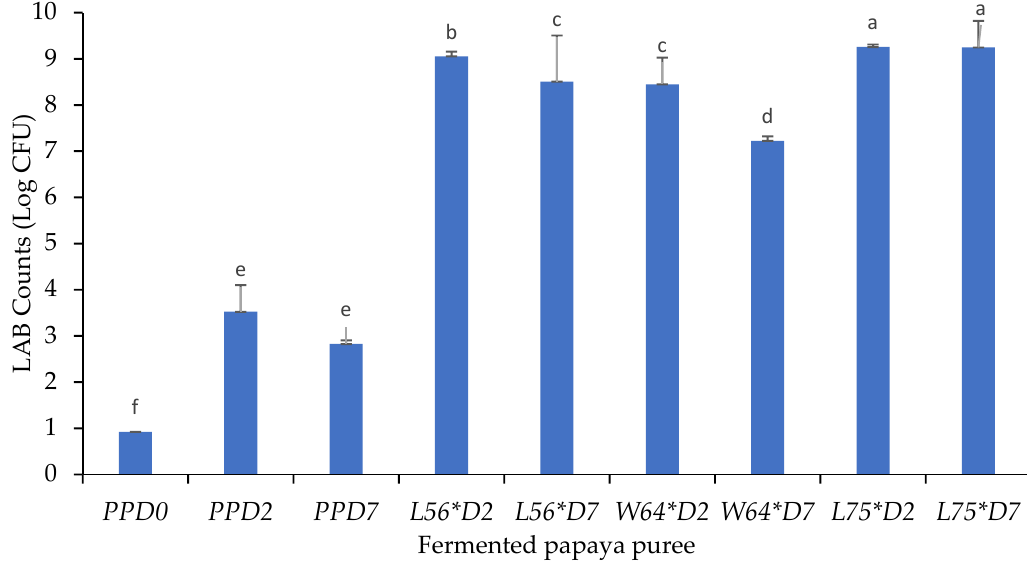
Figure 1. Surviving lactic acid bacteria counts in papaya puree. Bar with different letters are significantly different are significantly different at p < 0.05.